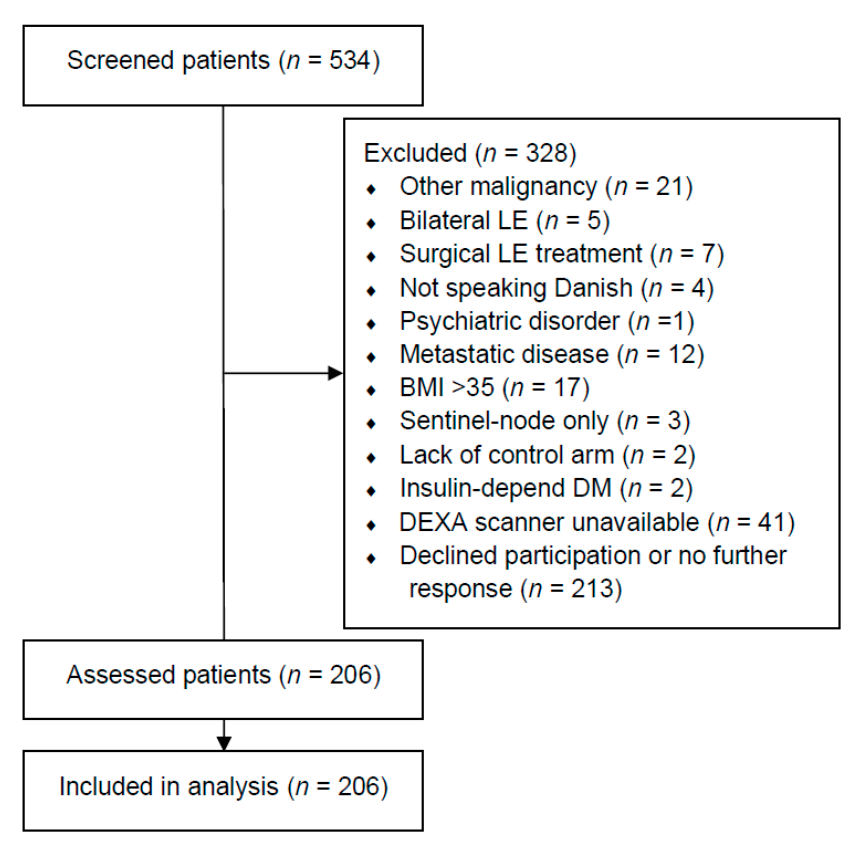
Figure 1. Flow chart of included patients. This table shows the flowchart of the include patients. LE = lymphedema. DM = diabetes mellitus. BMI = body mass index. DEXA = dual-energy X-ray absorptiometry.